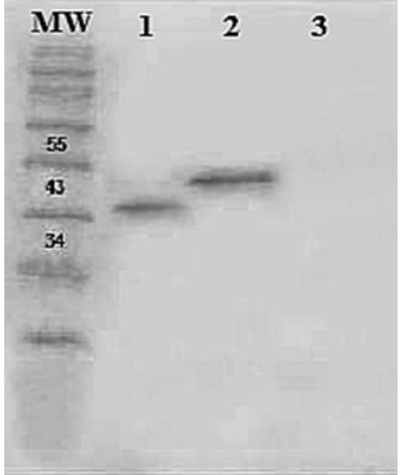
Fig. 4. Western blot showing the comparison of banding patterns of the fused protein and 50 kDa known protein: Line1= fused protein; Line 2= known protein (~50 kDa) as a positive control; Line 3= negative control (transformed E. coli with empty vector); MW= Molecular weight